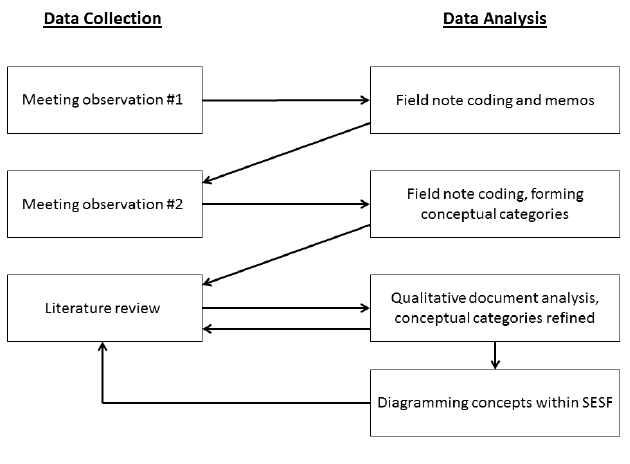
Fig. 1 . Sequence of data collection and analysis. (SESF: social- ecological system